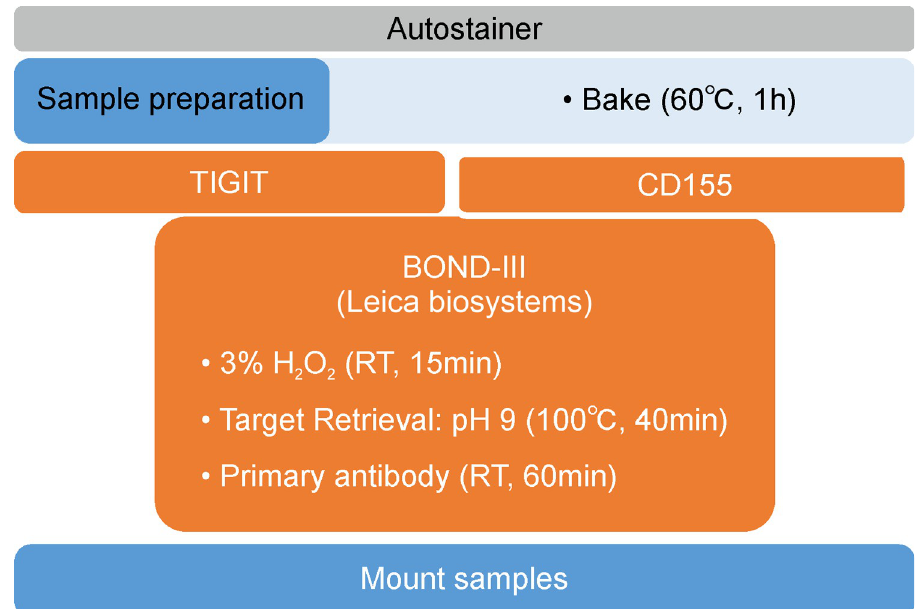
Fig 1. An overview of immunohistochemical staining of CD155 and Ig and ITIM domains